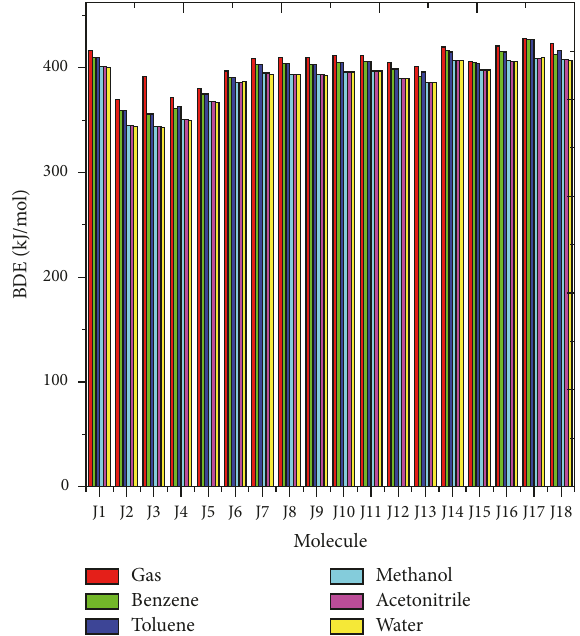
Figure 3: Bond dissociation energies of J 𝑛 (in kJ/mol) at B3LYP/6- 31+G(d,p) level in various